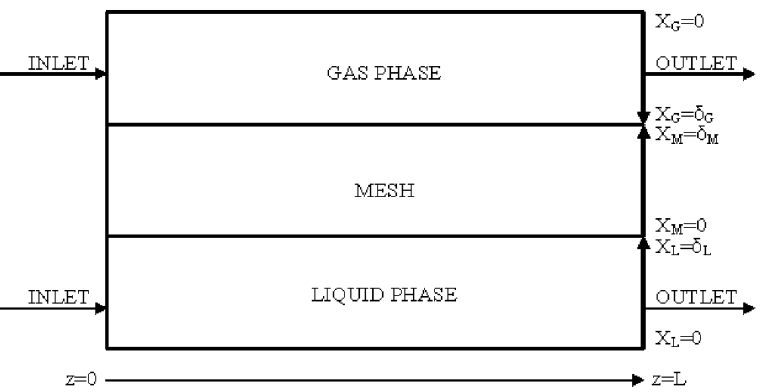
Figure 1. Schematic representation of the mathematical modelling domains with coordinates and boundaries.